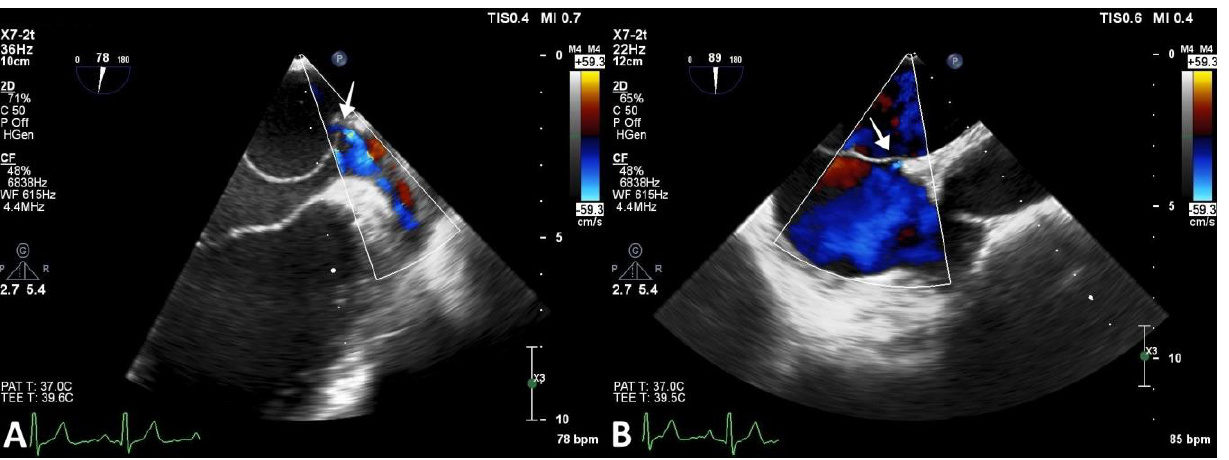
Figure 4. Transesophageal echocardiography revealing CTS. ( A ) Image showing openings in the CTS membrane (arrow). ( B ) PFO with minimal spontaneous left-to-right shunt (arrow).